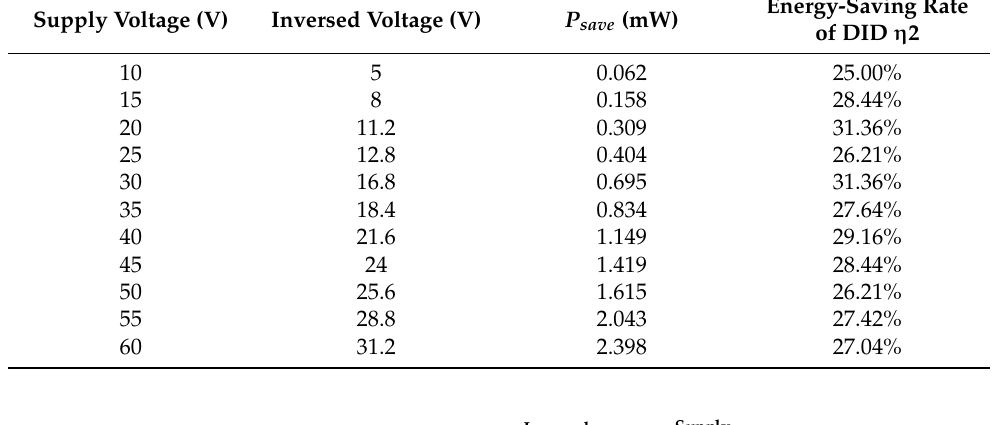
Table 4. Power and energy-saving rate at different voltages of DID circuit.